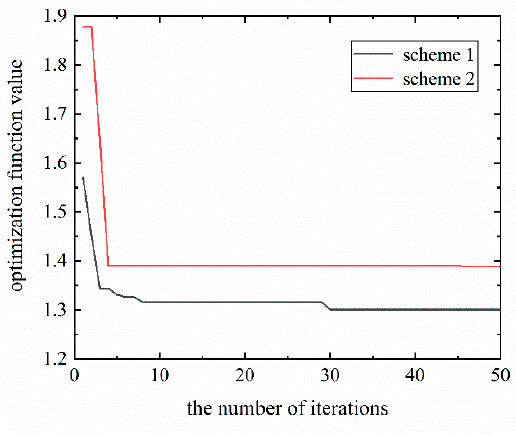
Figure 14. Convergence curve.